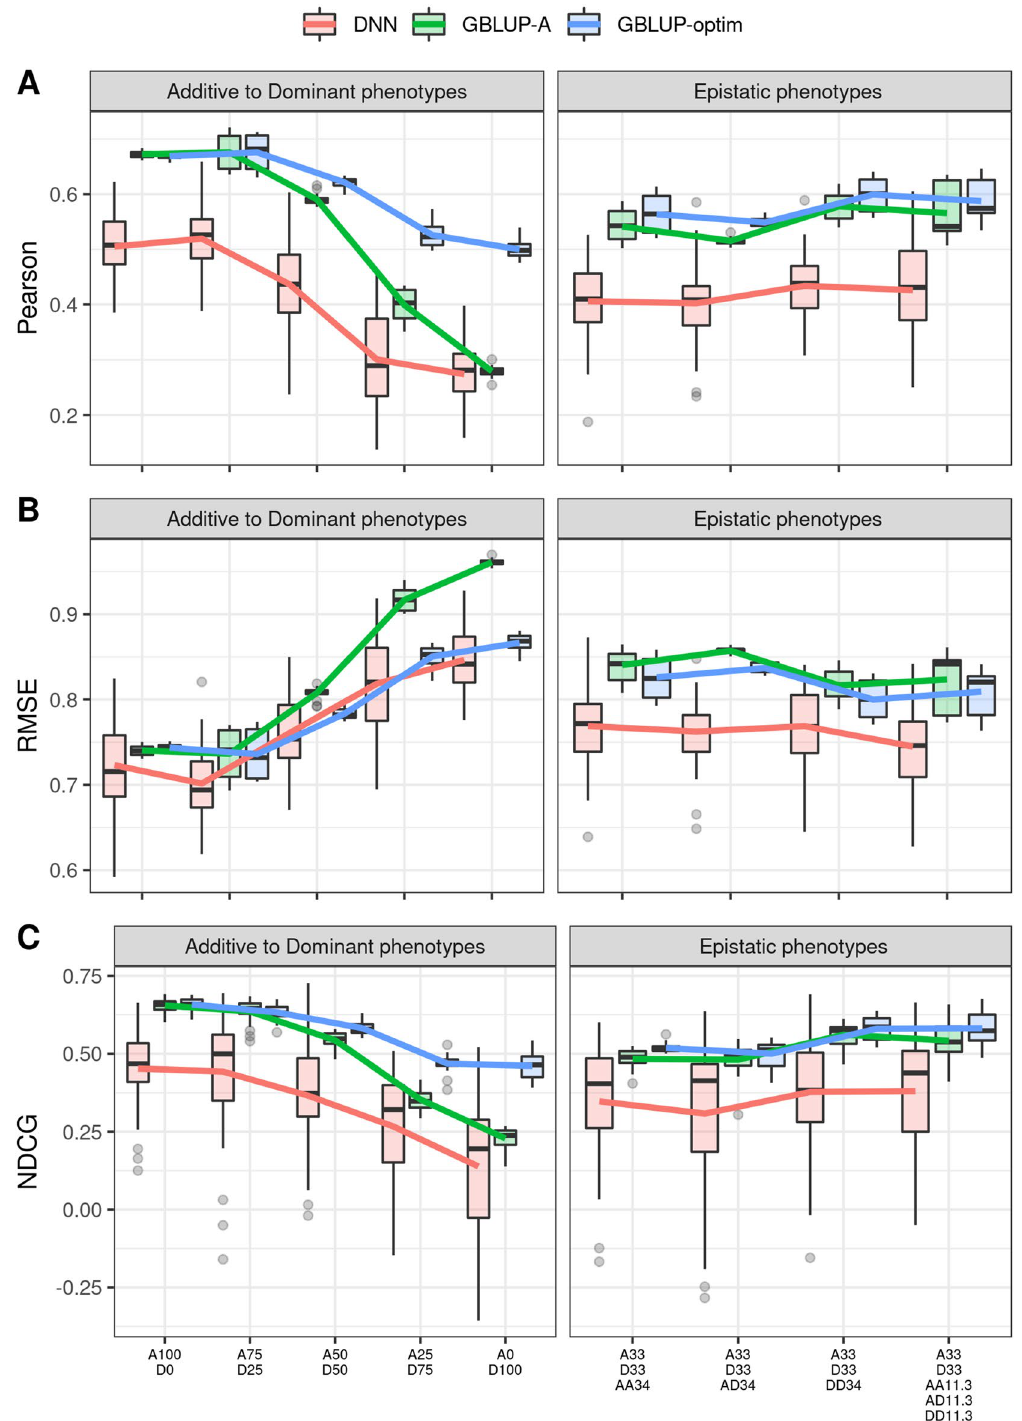
Figure 5. Predictive ability of deep learning and GBLUP models for the prediction of phenotype with different proportions of additive, dominance and epistatic effects. Performance is expressed in terms of: ( A ) Pearson’s correlation; ( B ) Root Mean Squared Error; ( C ) Normalized Cumulative Discounted Gain. Boxplots show the median and distribution of predictive ability. Solid lines represent the average predictive ability under the different